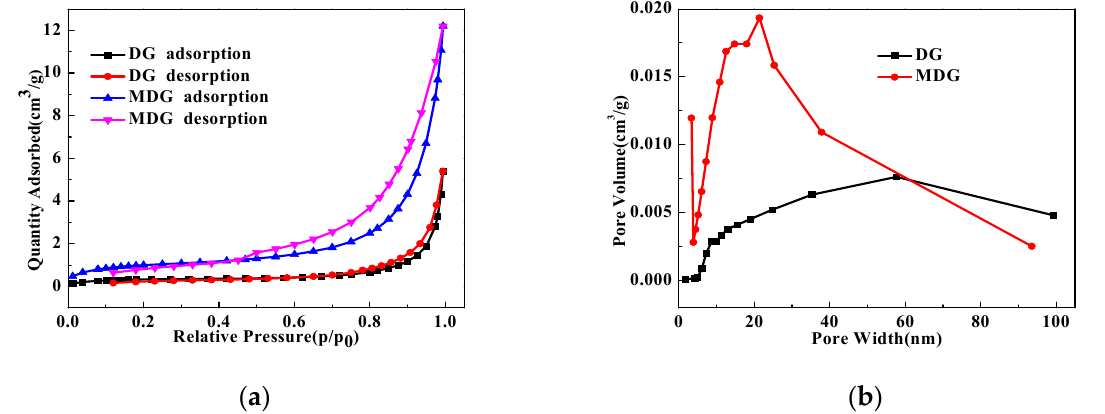
Figure 8. ( a ) N 2 adsorption-desorption isotherm and ( b ) pore size distribution of DG and MDG. Table 1. The pore structure parameters of DG and MDG.